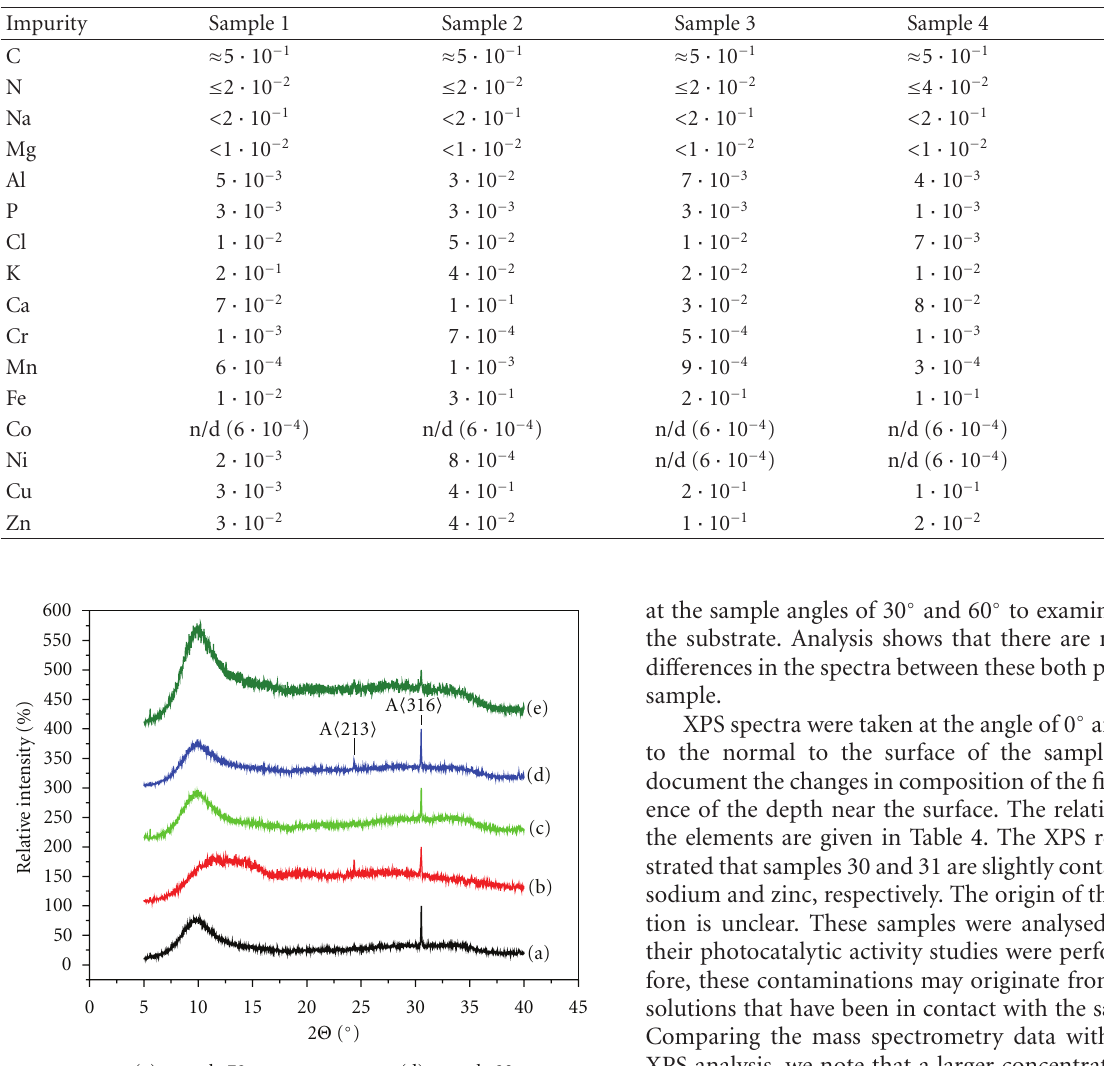
Table 2: The results of mass-spectrometry analysis; the values are shown in %. n/d: not detected; the detectability threshold is given in brackets.